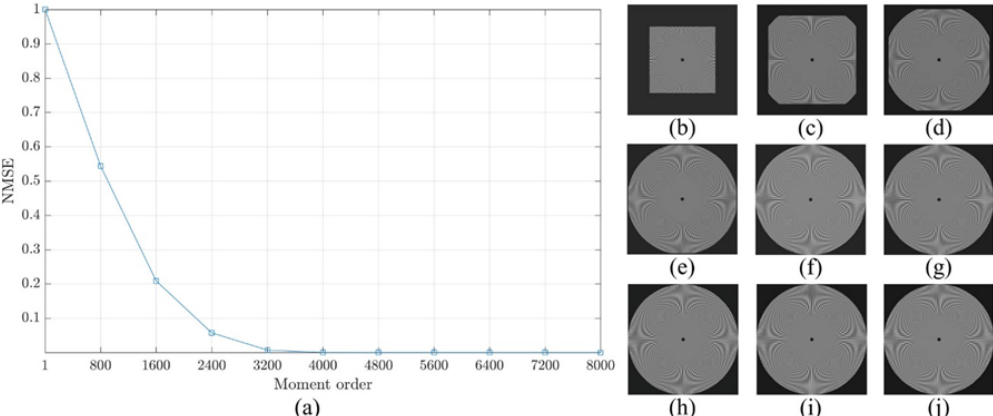
Figure 11. Construction analysis for the proposed method using sinusoidal Siemens start with ω = 200. ( a ) NMSE, image reconstructed using number of moment equal to ( b ) 800, ( c ) 1600, ( d ) 2400, ( e ) 3200, ( f ) 4000, ( g ) 4800, ( h ) 5600, ( i ) 6400, and ( j ) 7200.